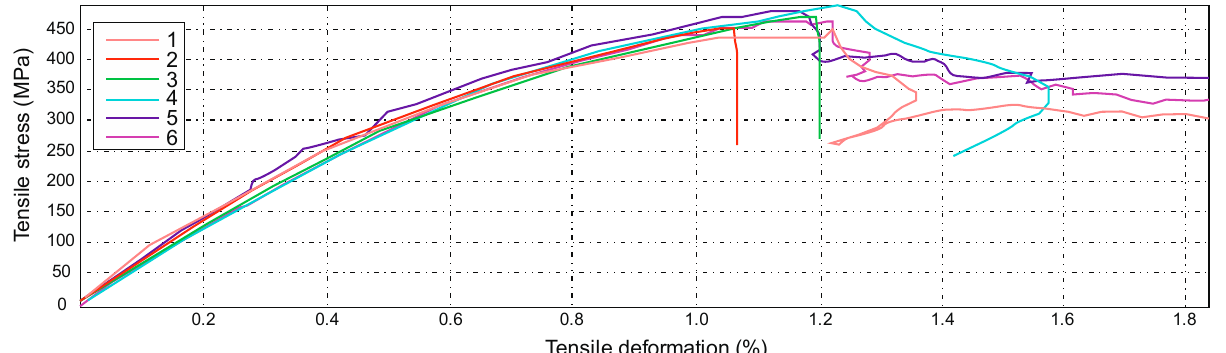
Figure 18. Graph showing the tensile stress and deformation of a laminate reinforced with IMS65 CTLX biaxial fabric, ± 45° configuration.